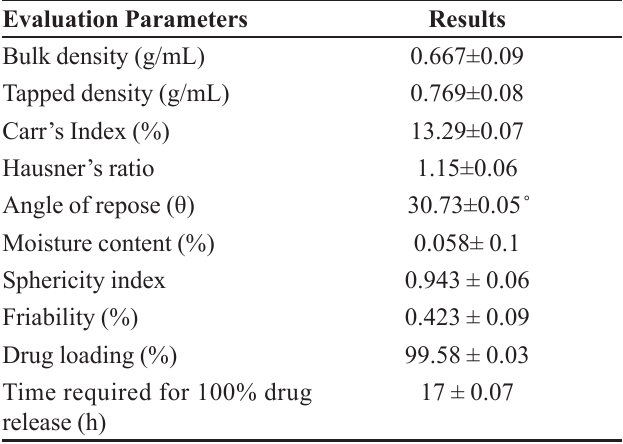
TABLE VIII - Results of evaluation parameters of optimized batch of methotrexate coated pellets (Batch B5) Evaluation